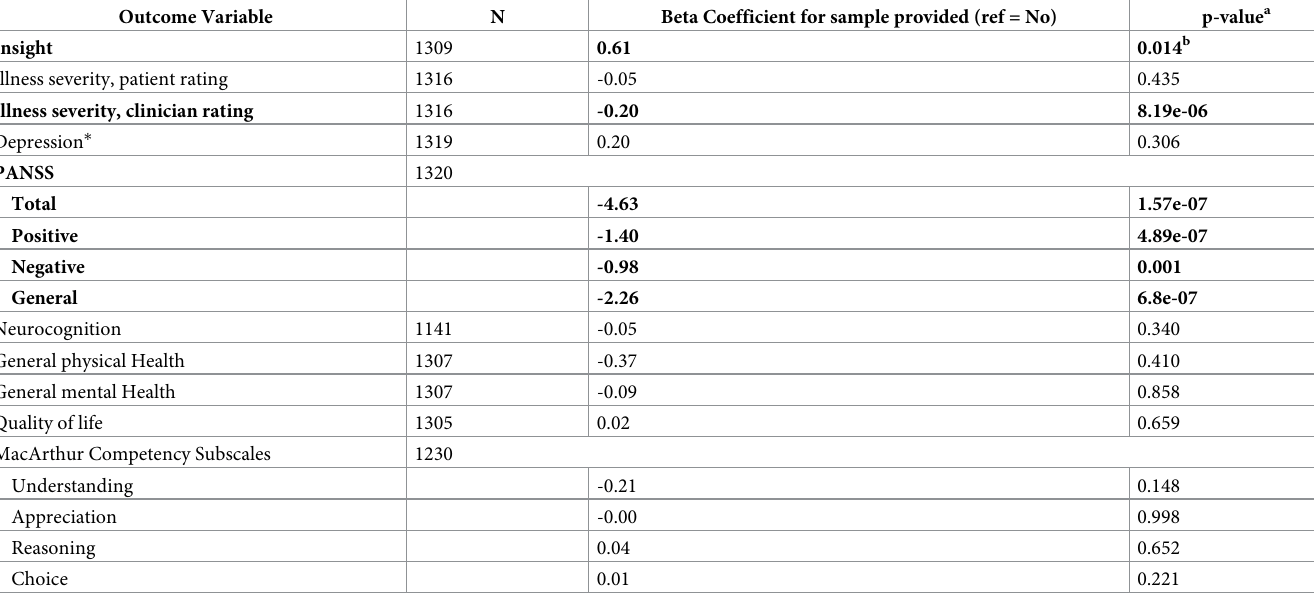
Table 4. Longitudinal changes in clinical variables by genetic sub-study